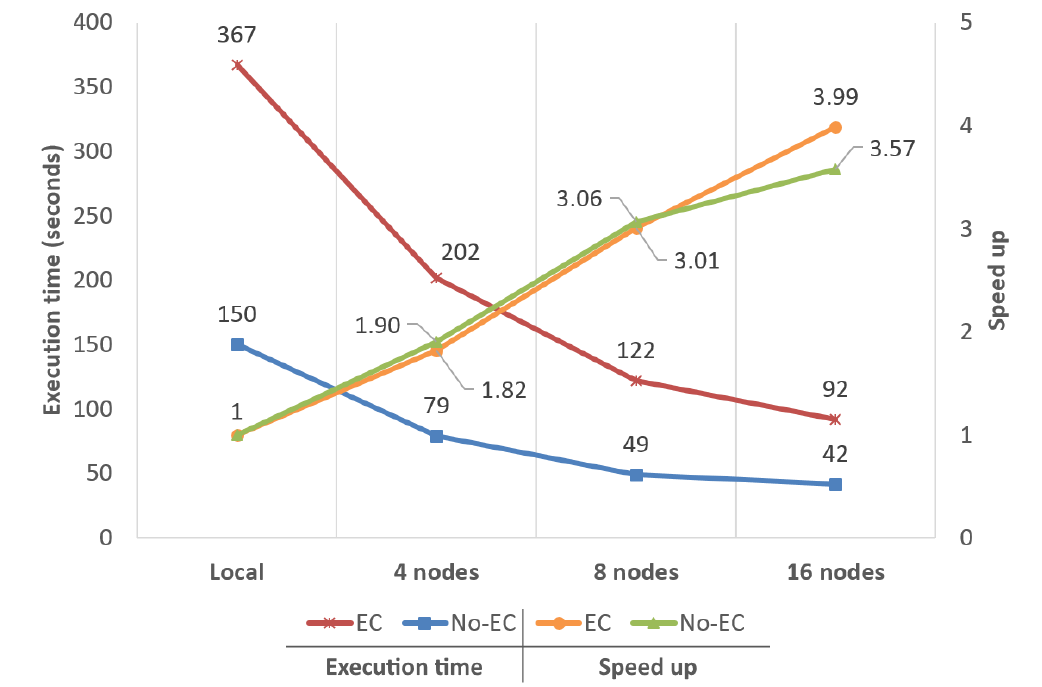
Figure 10. Performance analysis and scalability comparison between the local version of the system and the big data approach using 4, 8 and 16 nodes. This test was carried out using dataset D3 to analyze the system under especially unfavorable